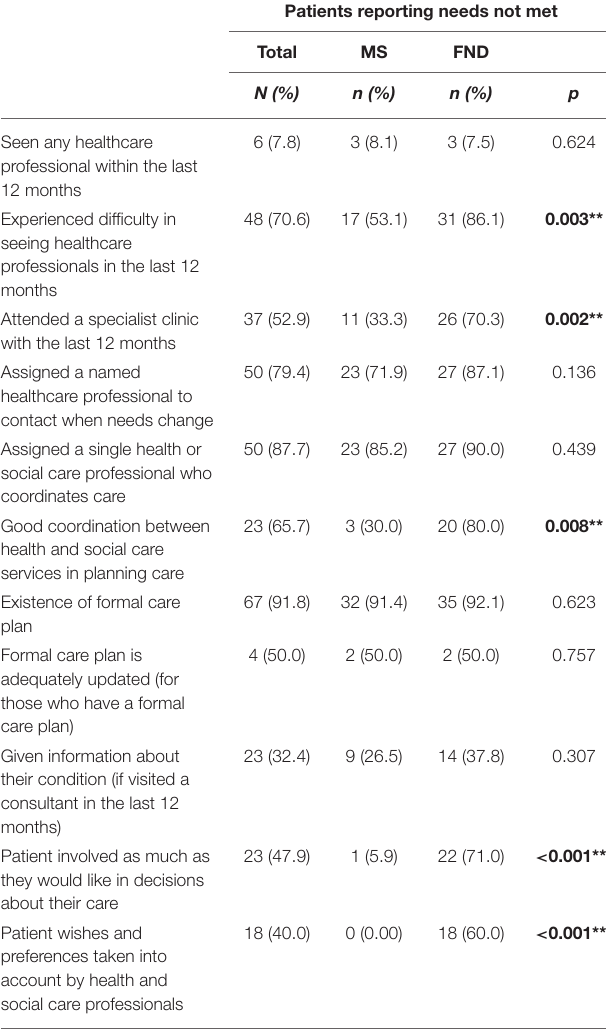
TABLE 1 | Patients reporting a problem regarding the diagnosis and treatment of their neurological condition. Patients reporting needs not met